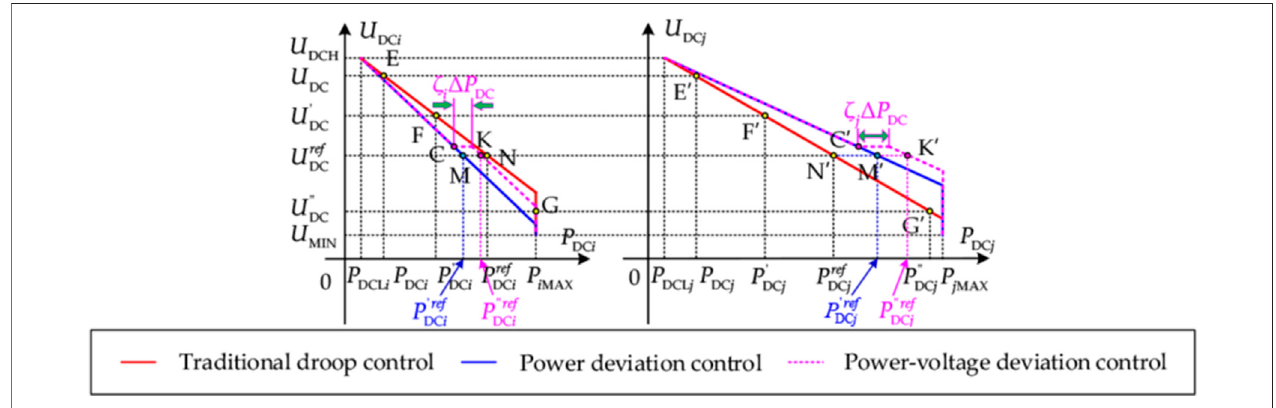
FIGURE 3 | Characteristic curves of U – P droop